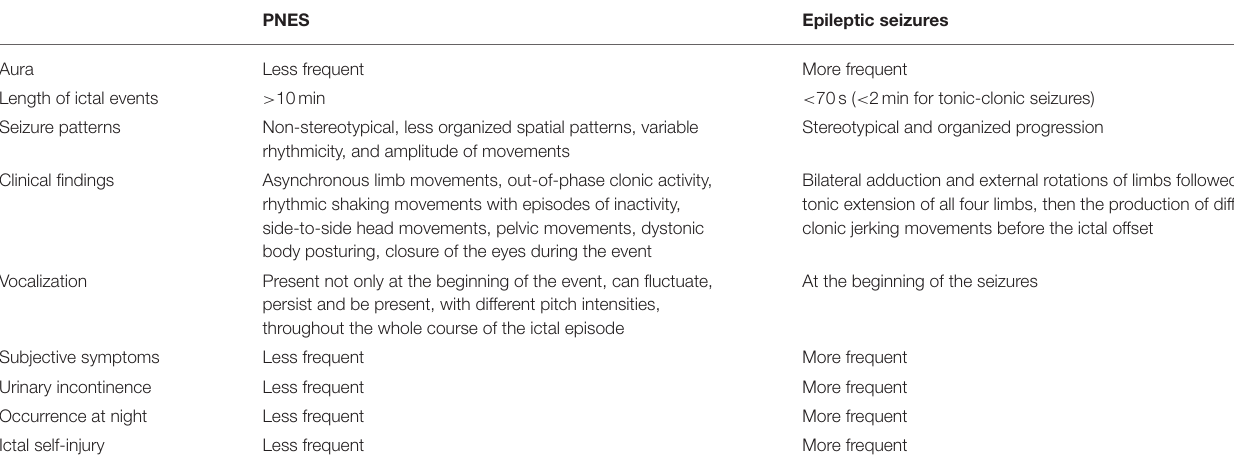
TABLE 3 | Differential diagnostic features PNES and epileptic seizures.